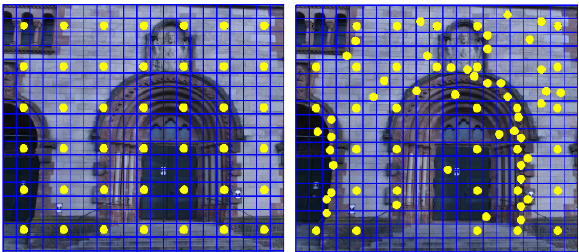
Figure 1 . Schematic diagram of the point cloud reprojection on the image with different shooting angles and building shapes. (a) the reprojection for the ideal case; (b) the reprojection for the actual